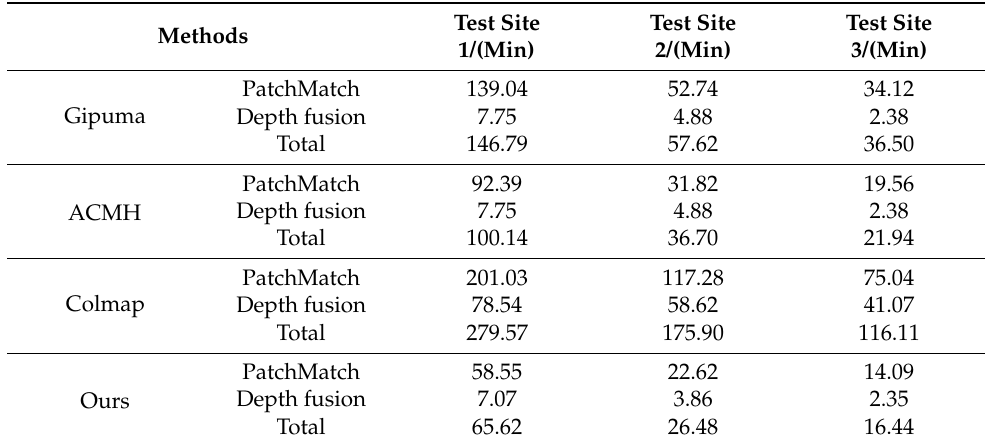
Figure 10. The comparison of total runtimes of dense matching and depth map fusion with differ- ent methods. Table 2. Details of the runtime of dense matching and depth map fusion with different methods for the three datasets in the high-voltage power transmission line.